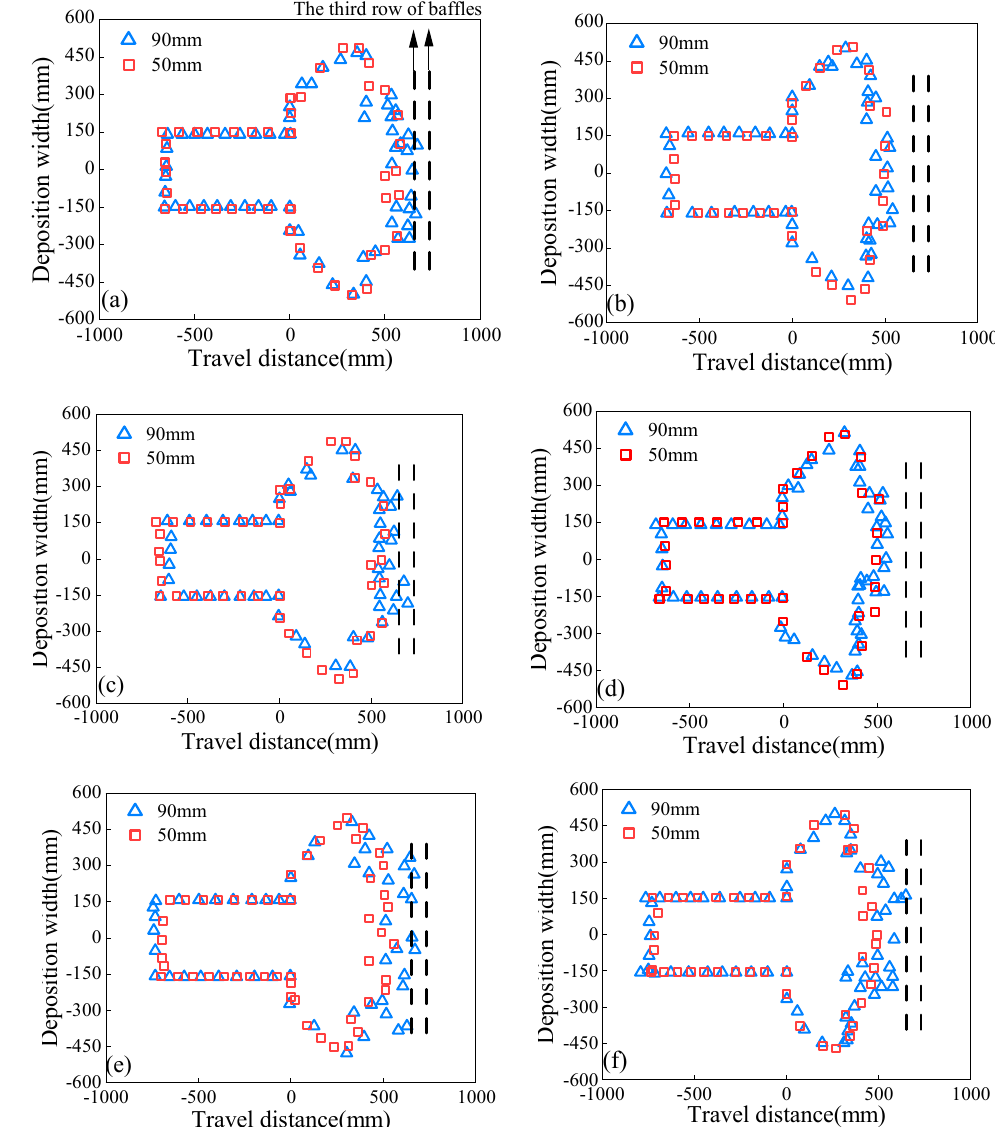
Figure 16. The influence of the distance between baffle openings on the effectiveness of debris flow interception: ( a ) Z1, ( b ) Z2, ( c ) Z3, ( d ) Z4, ( e ) Z5, ( f ) Z6.